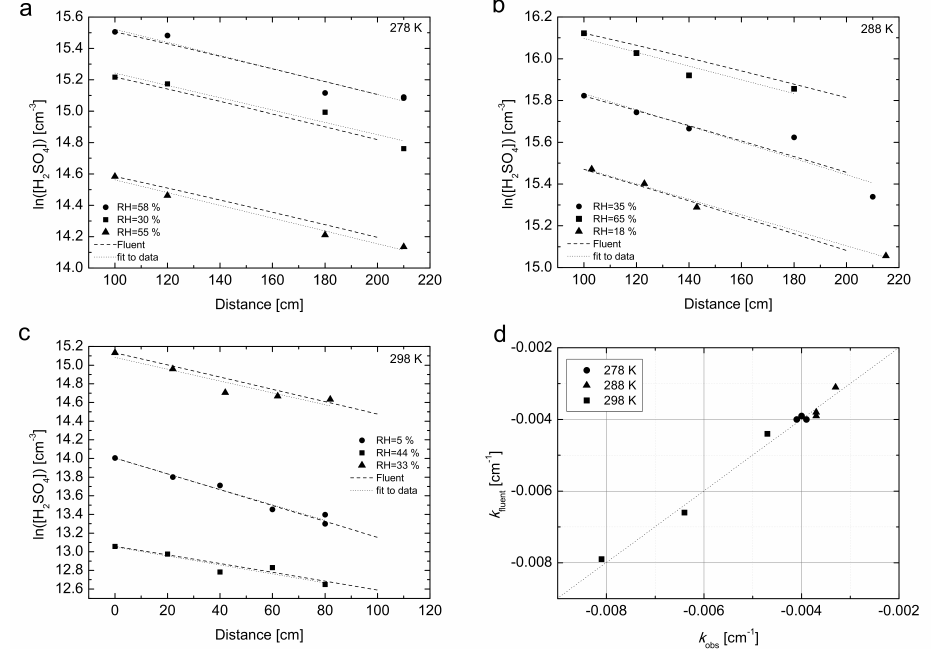
Figure 4. The sulfuric acid losses simulated with CFD FLUENT model when the experimentally obtained diffusion coefficients are used as an input at ( a ) T = 278 K; ( b ) T = 288 K and ( c ) T = 298 K. ( d ) simulated losses rate coefficients compared with experimental values of k obs (cm − 1 ) at T = 278, 288 and 298 K. The instances of each symbol in panel ( d ) represent loss rate coefficient at different relative humidities, the lowest relative humidity having the steepest slope (the highest absolute value of loss rate